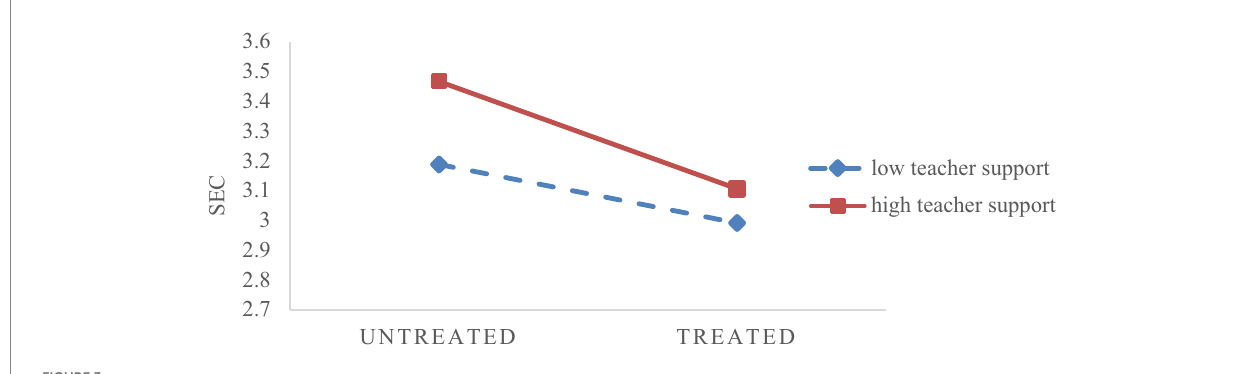
FIGURE 3 Moderating effect of teacher support on the relationship between left-behind and non-left-behind children’s